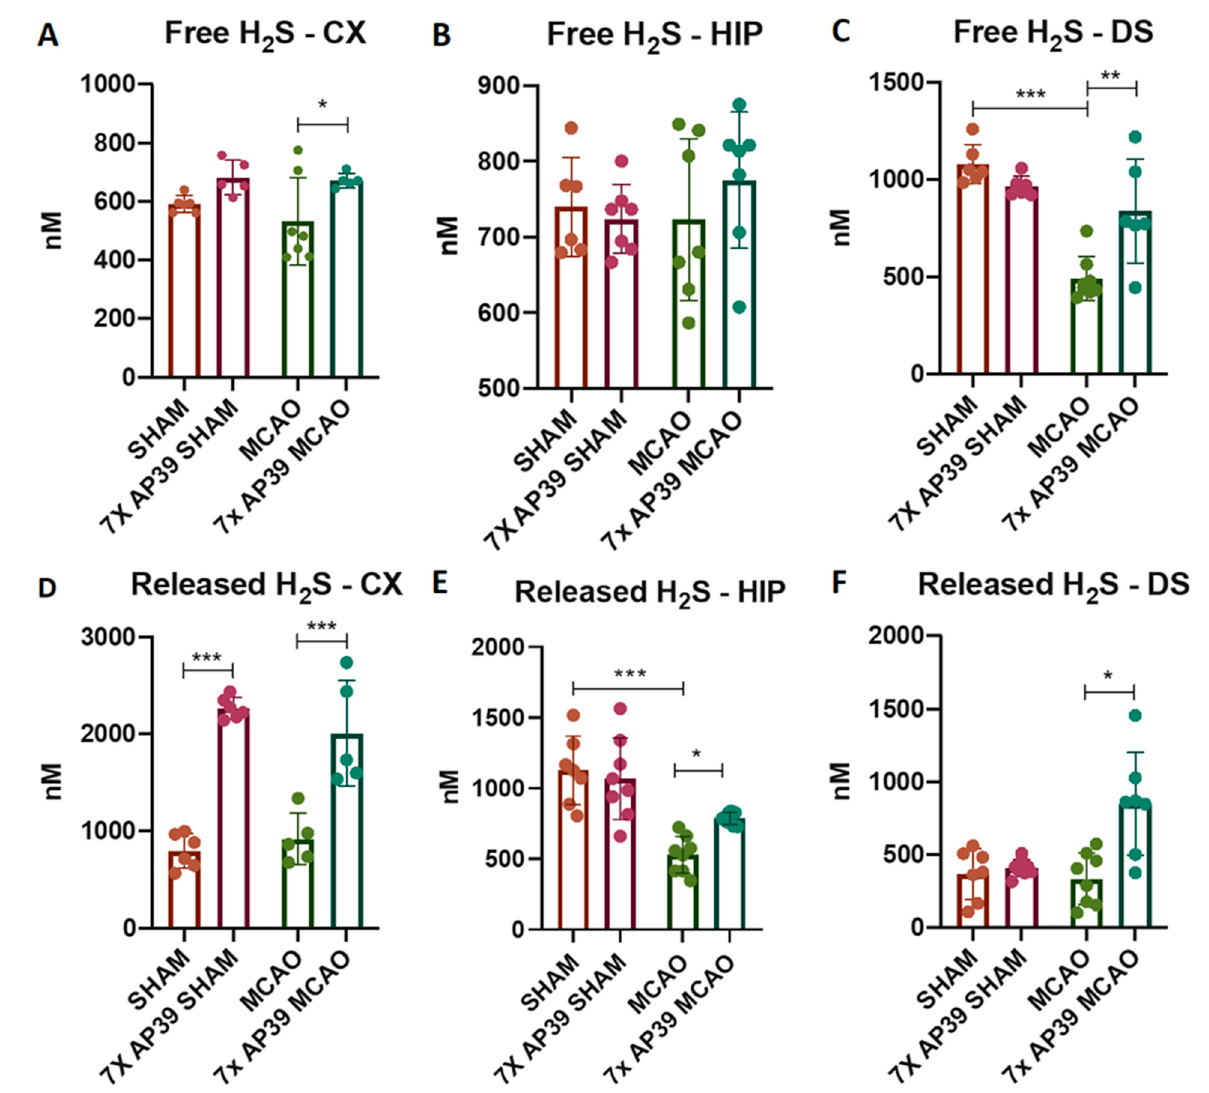
Figure 2. The effect of MCAO and AP39 on the levels of ( A – C ) free H 2 S and ( D – F ) DTT-released H 2 S in the frontal cortex (CX), hippocampus (HIP) and in the dorsal striatum (DS), n = 8, one-way ANOVA, followed by Sidak’s correction for post hoc comparisons; * p < 0.05, ** p < 0.01 and *** p < 0.001 vs. MCAO or SHAM. Data are presented as the mean ± SD.